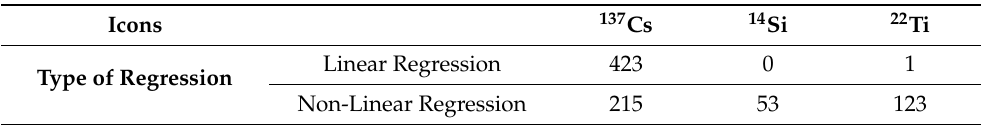
Table 6. Regression analyses of differentially expressed